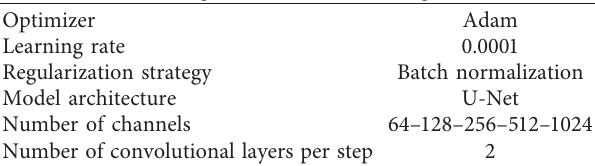
Figure 9: Validation performance with respect to the (a) number of convolutional layers and (b) number of channels. Table 4: Segmentation model